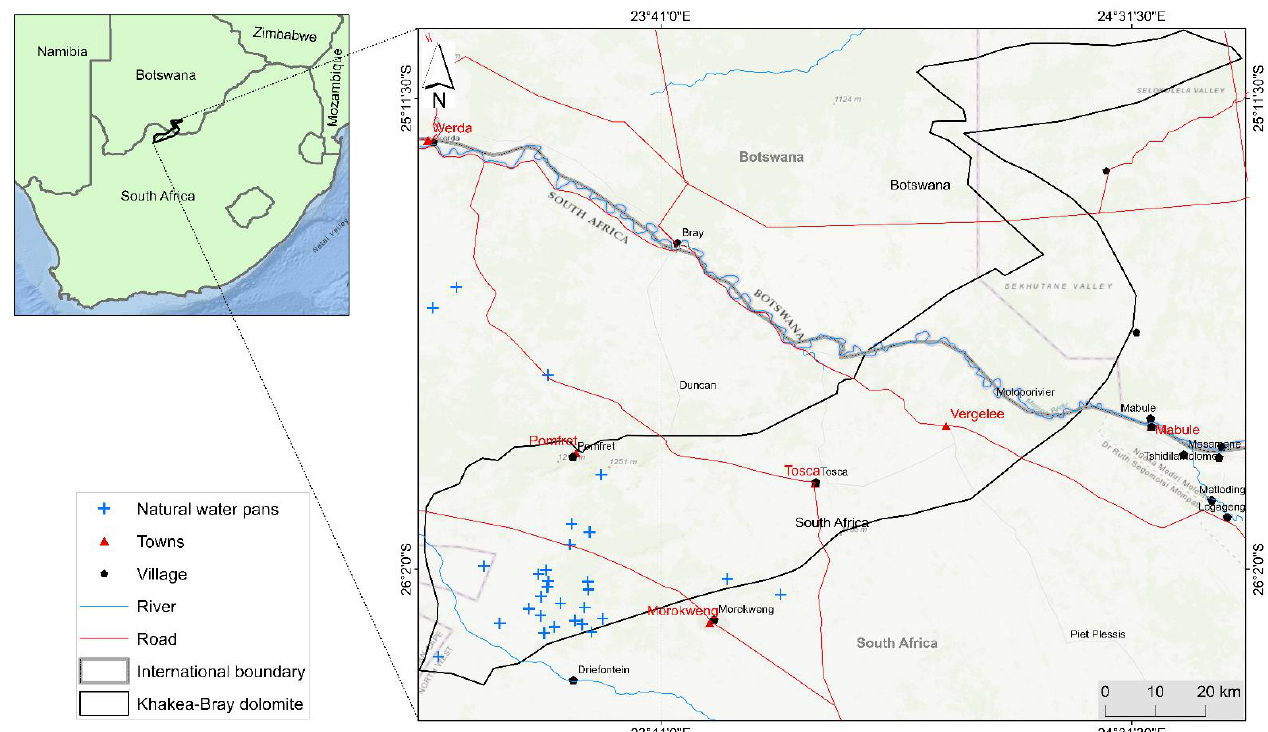
Figure 1. Map of the Khakea-Bray TBA spanning across Botswana and South Africa. The study is overlaid on baseline topography imagery accessed from ArcMap [49].